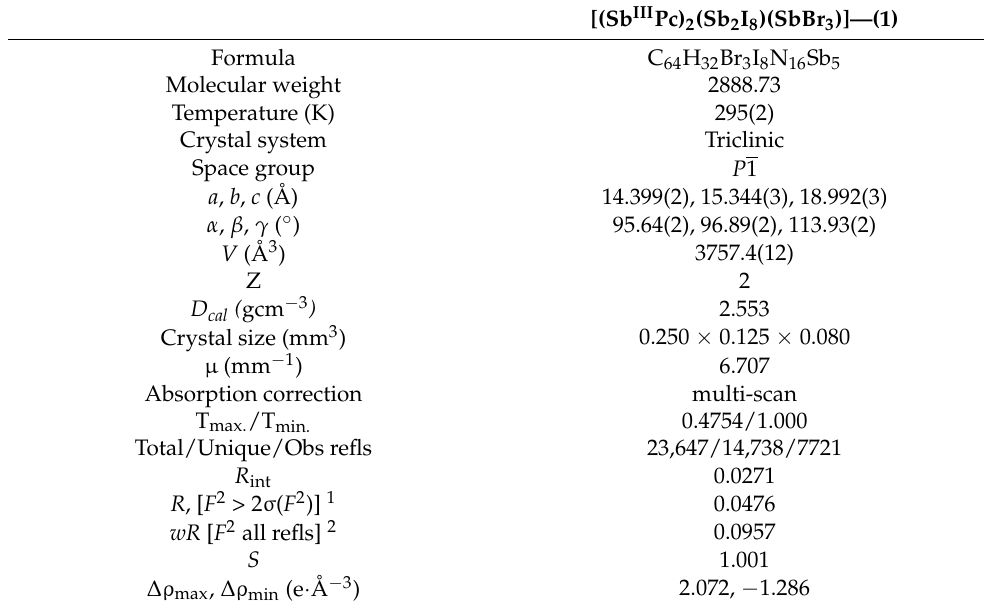
Table 1. Crystal data and final refinement parameters for 1